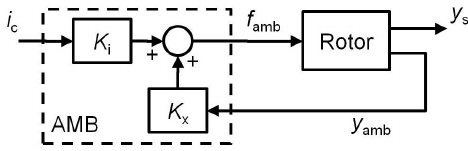
Figure 14. Rotor-AMB system block diagram.